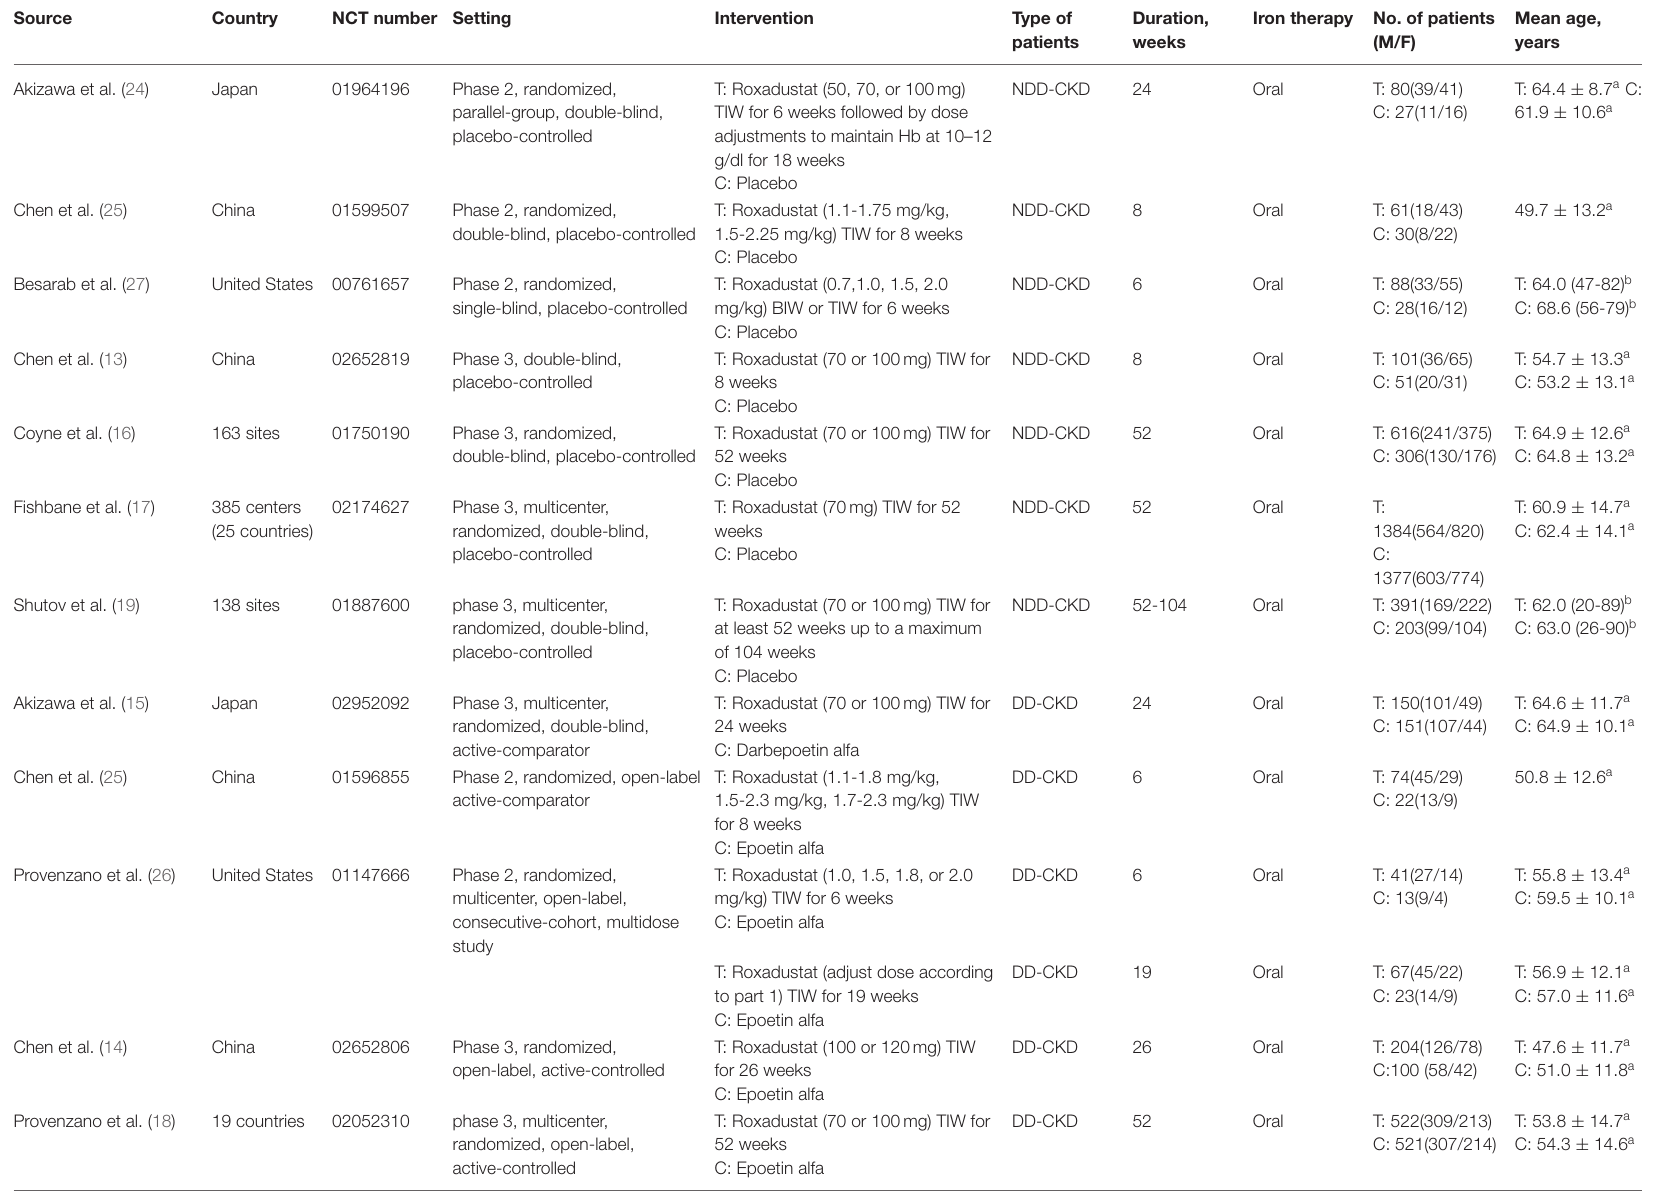
TABLE 1 | Characteristics of the included